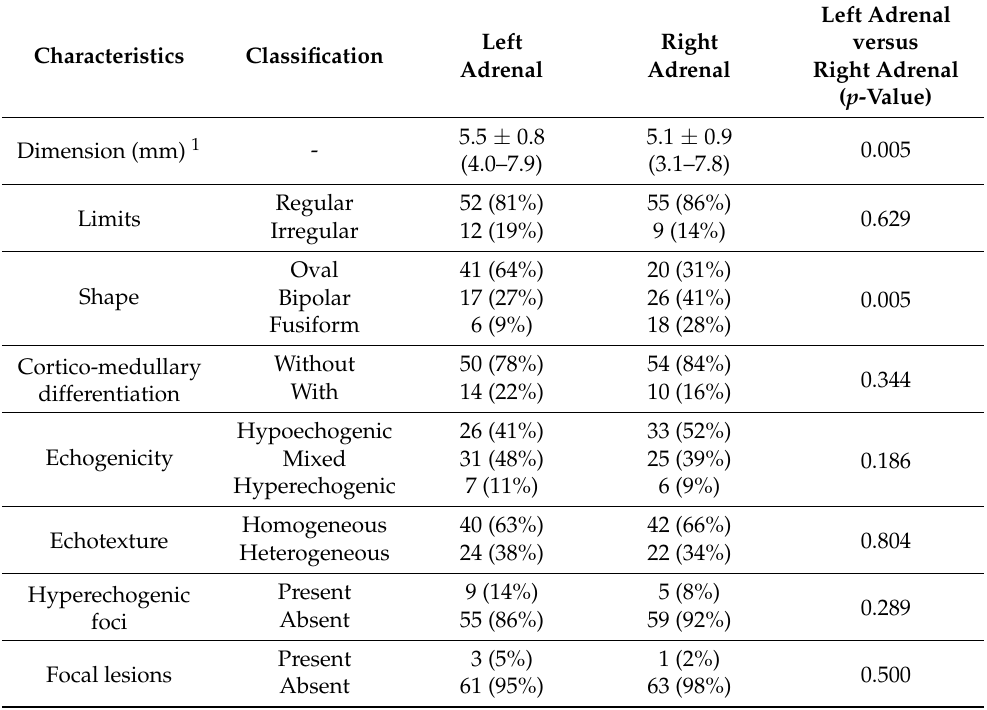
Table 2. Ultrasound findings of the left and right adrenals in clinically ill cats showing adrenomegaly (either uni or